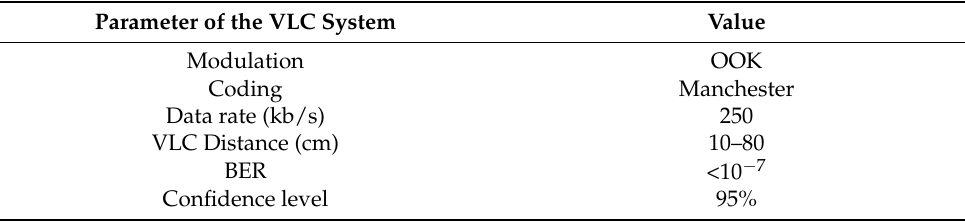
Figure 11. Graphical user interface displaying the parameters of the communication. Table 5. Summary of the experimental results for the proposed setup.